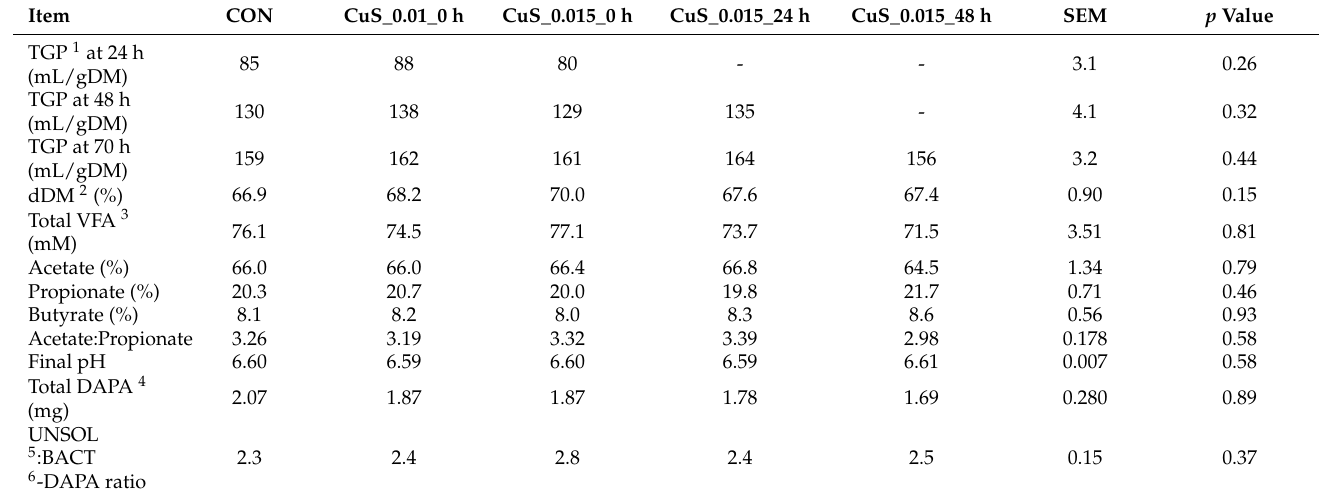
Table 7. Influence of CuSO 4 dose and addition time on fermentation parameters.